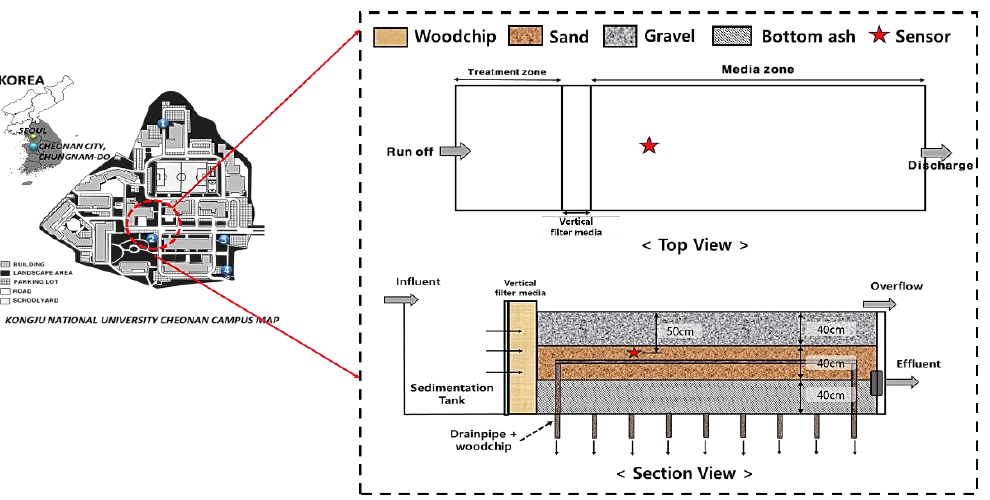
Figure 1. Schematic diagram of the infiltration trench. Table 1. Characteristics of the infiltration